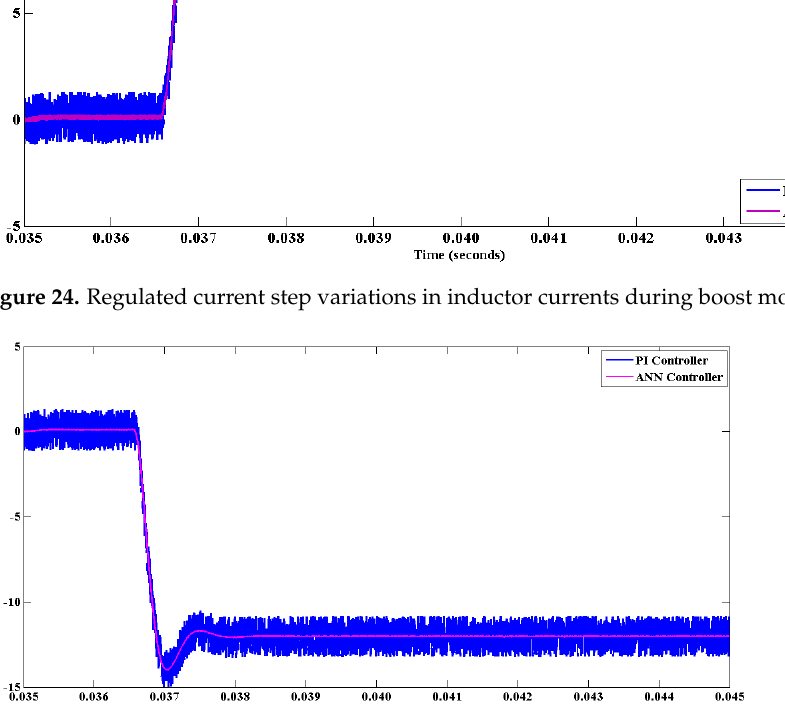
Figure 25. Regulated current step variations in inductor currents during buck mode.